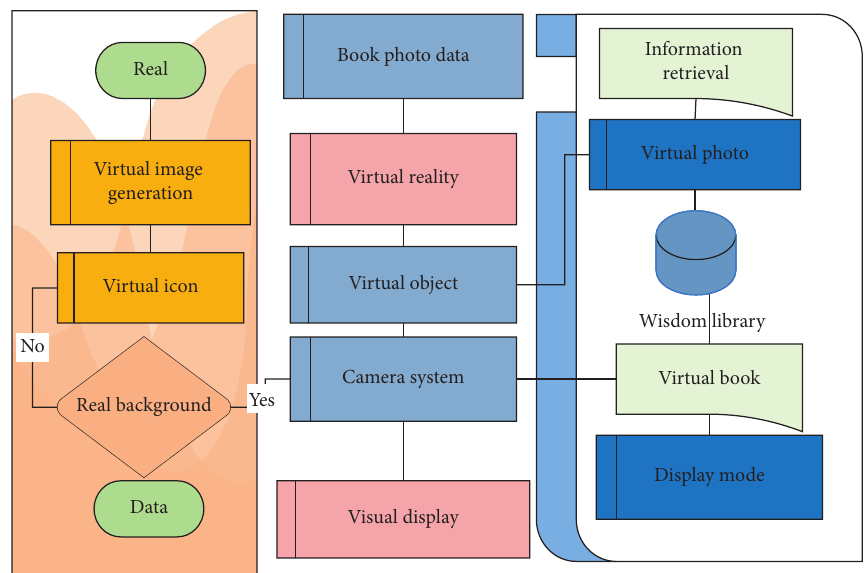
Figure 2: Operating principle model of virtual reality technology display mode based on computer screen